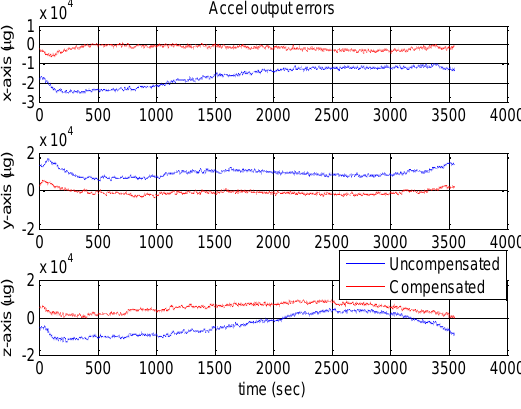
Figure 14. NV-IMU100 accelerometer output errors with and without compensation.